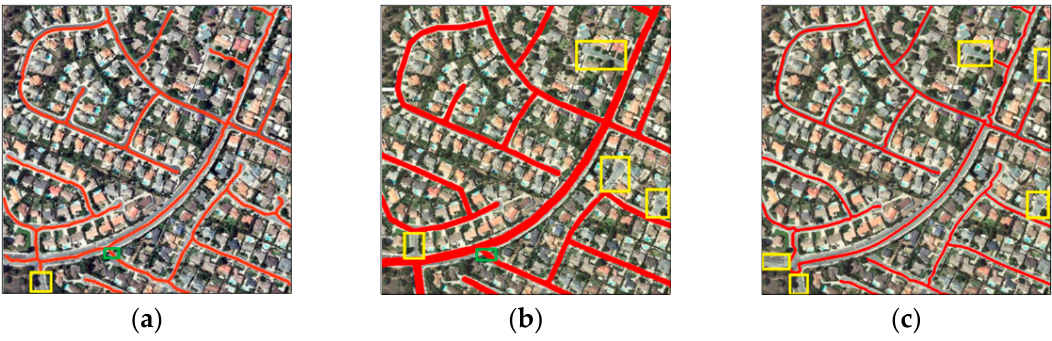
Figure 6. Extraction results of the first study area: ( a ) result of the proposed method; ( b ) result of Poullis 2014 (adapted from [12]); ( c ) result of Miao 2013 (adapted from [13]).